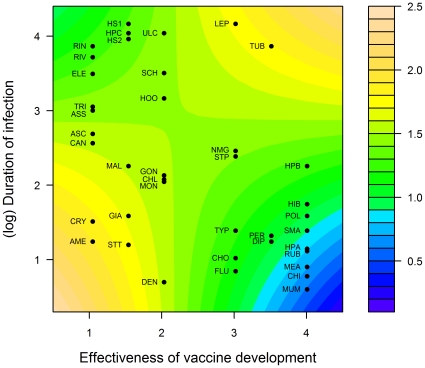
Levels of genetic variation in susceptibility in relation to the effectiveness of vaccine development and the duration of the infectious period.Color key indicates level of variation in susceptibility. Purple/blue corresponds to low levels of variation in susceptibility, while yellow/orange corresponds to high levels of variation in susceptibility. Response surface is based on a multiple regression model (see text for explanation).